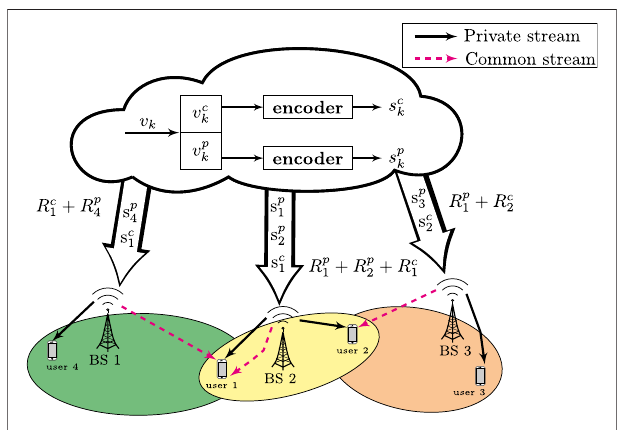
FIGURE1| AC-RANinthedownlinkwiththreeBSsandfourusers.User 1 receives both its private and common messages from BS 2, while user 2 receivesits private message from BS 2and thecommon message from BS